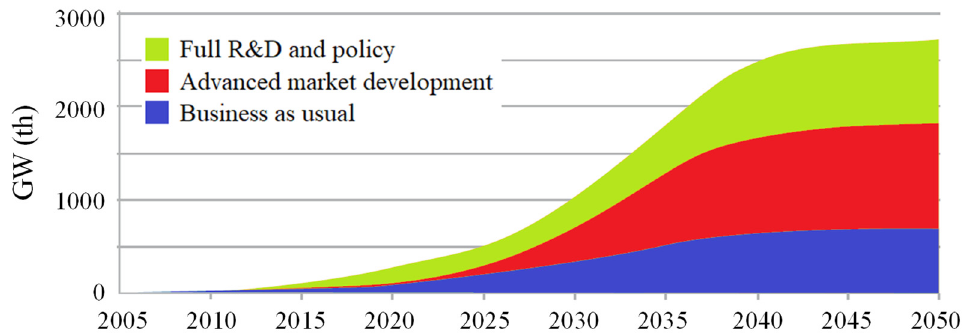
Figure 1. Development of solar thermal capacity in Europe according to 3 different scenarios (2005–2050). Raw data extracted from Ref. [6].